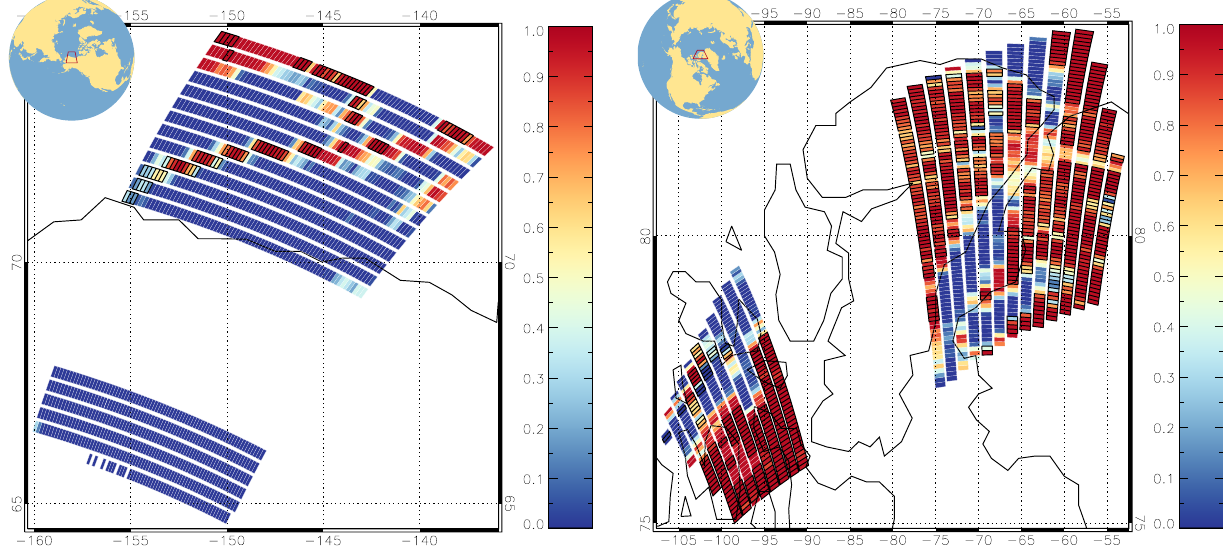
Fig. 5. Snow fraction, the number of cloud-free snow-covered scenes observations by AATSR divided by the total number of AATSR scenes inside each collocated SCIAMACHY PMD scene, as indicated by the colorbar on the right. Each footprint indicated by SPICI as cloud-free snow covered scene has been outlined in black. Left panel: 6 May 2004, right panel: 5 May